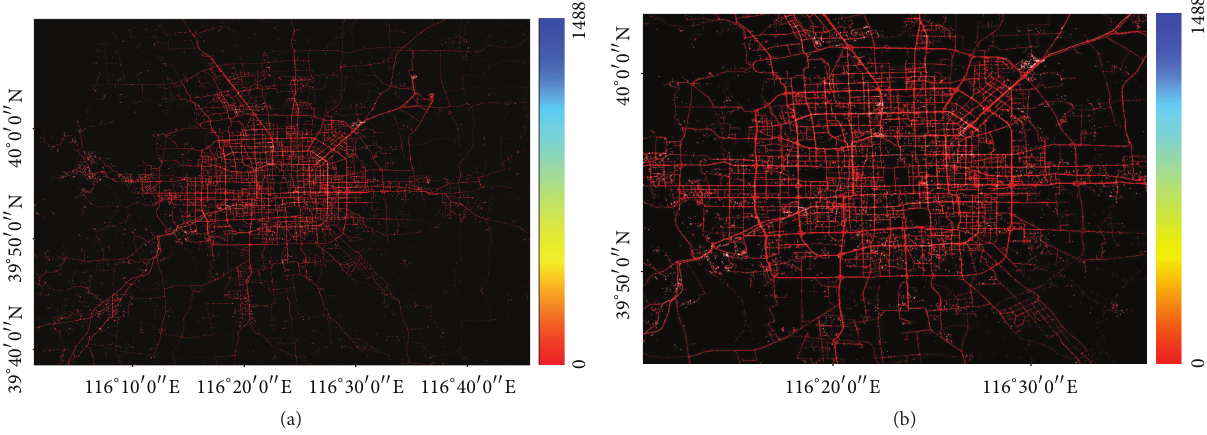
Figure 1: Road network produced via GPS points of taxi trajectories with density distribution. (a) Overview of Beijing and (b) the 5th Ring Road of